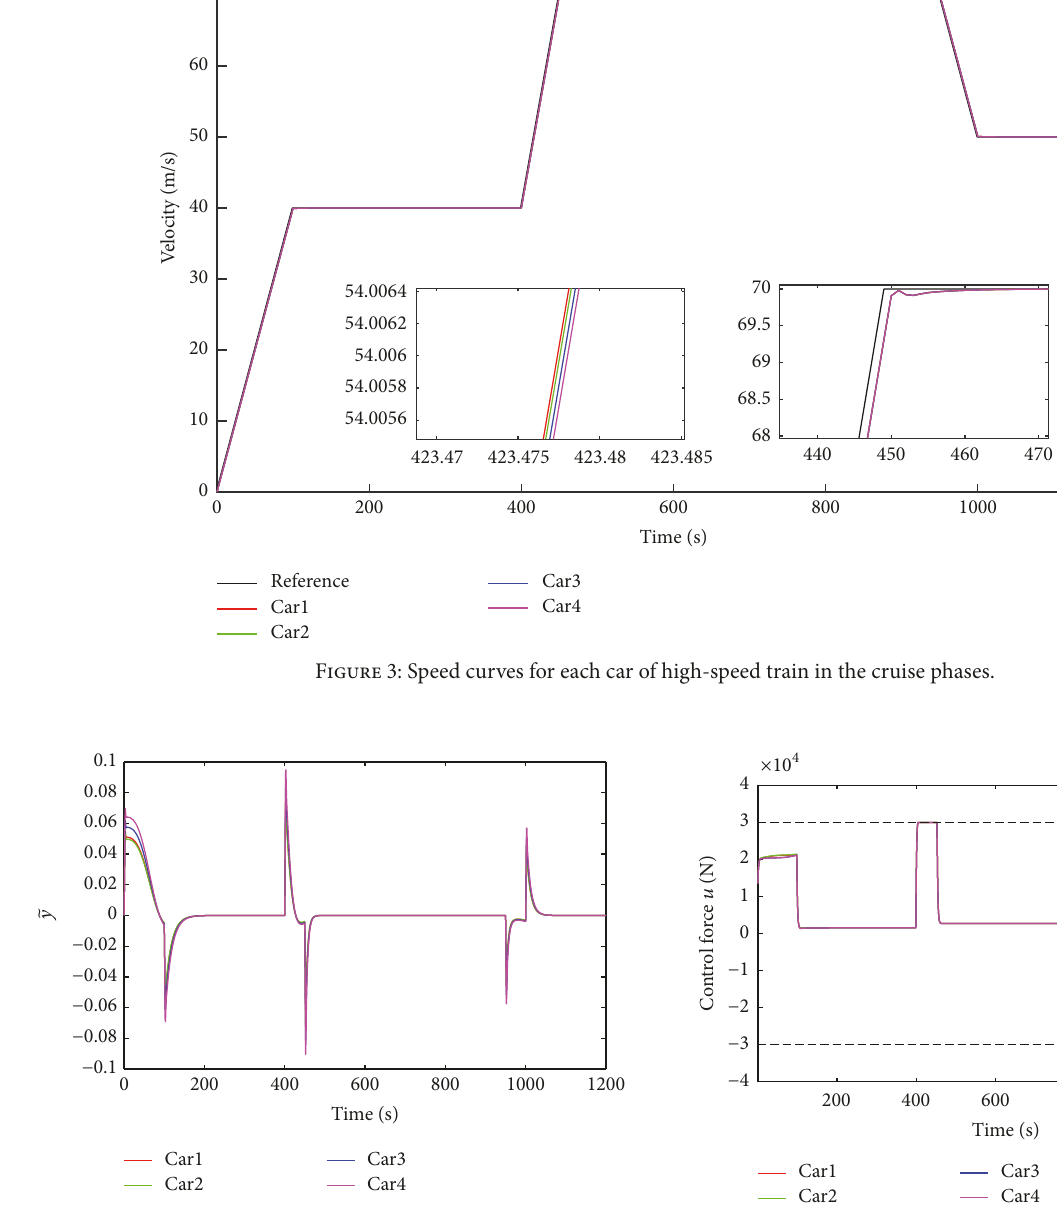
Figure 4: Estimated output errors.